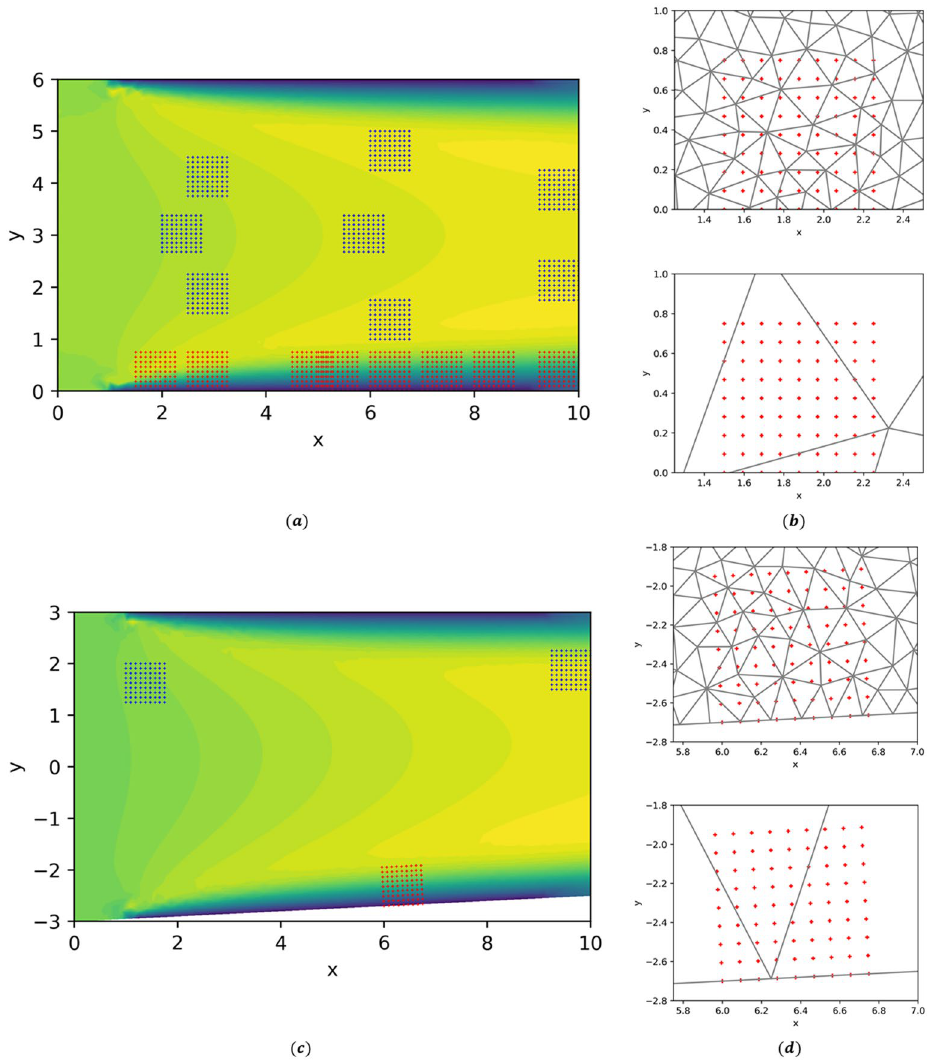
Figure 4. ( a ) A visualisation of the two-dimensional channel flow used to train the KBaNNs. The locations of the sample grids used to harvest velocity data are superimposed. Blue grids correspond to sample grids in the freestream, red to grids that bound the wall and capture the boundary layer. ( b ) Close ups of the mesh near the wall of the channel, with a sample grid superimposed. ( c ) A simulation of the flow over a slightly converging channel was included in the validation data set to prevent overfitting ( d ) the spatial resolution of the two meshes was kept the